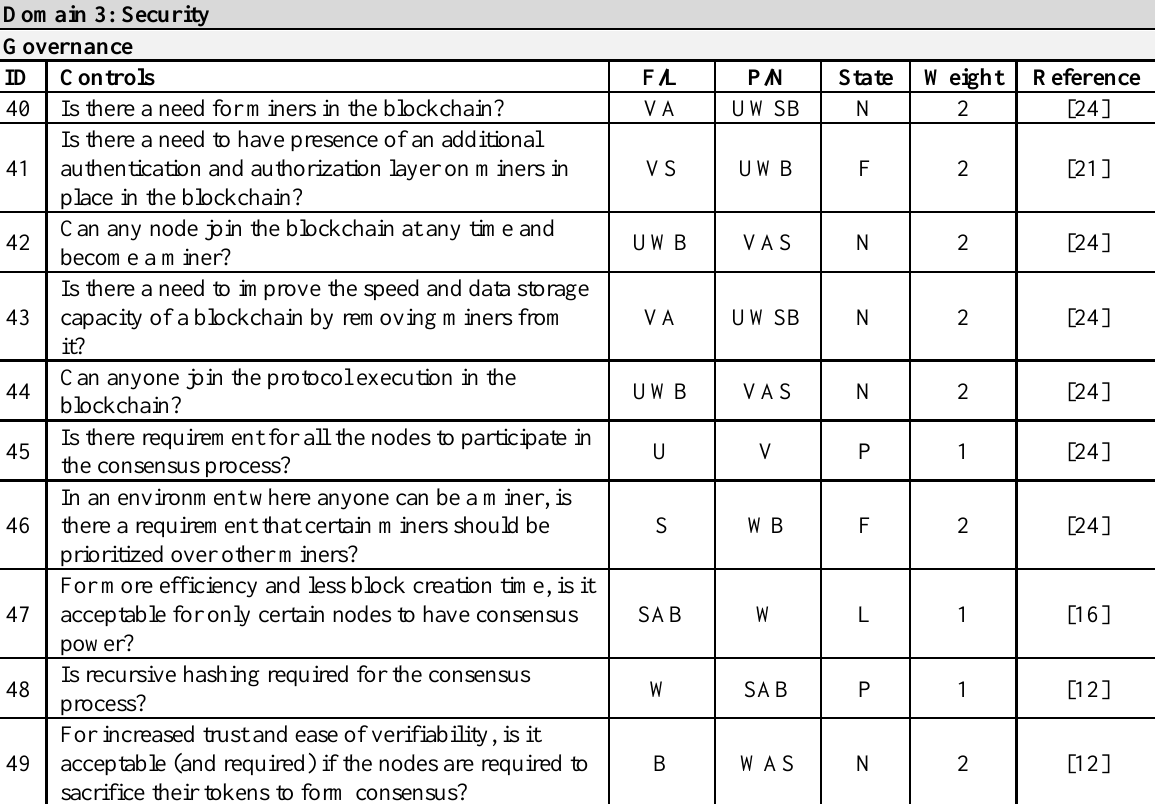
Table 4. Domain 3 of the blockchain applicability framework